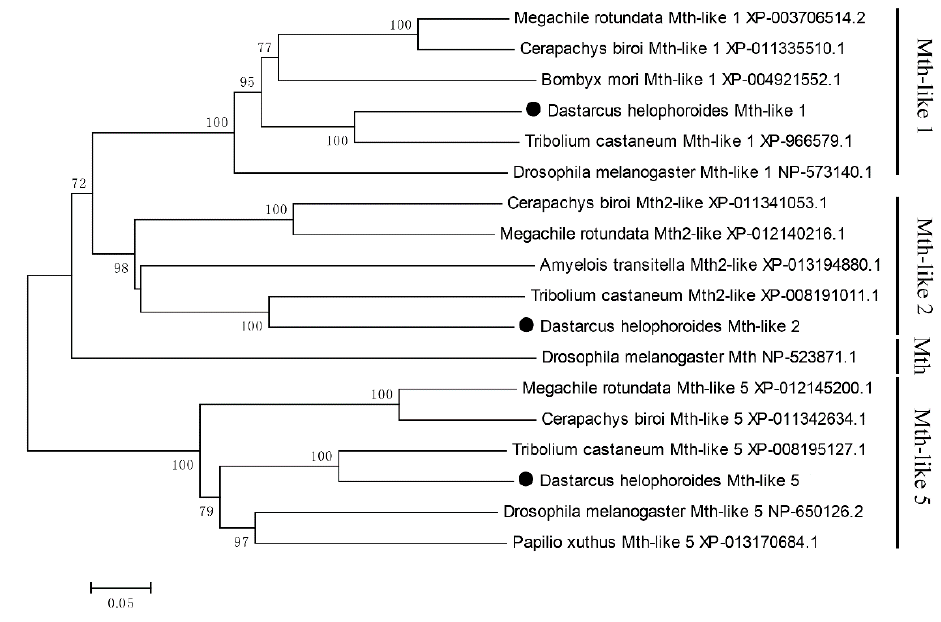
Figure 2. Molecular phylogenetic analysis by the neighbor-joining (NJ) method. Bootstrap values with 1000 trials re-indicated on the branches. GeneBank accession numbers of amino acid sequences used to generate the tree are shown in the Figure. D. helophoroides sequences are marked by a black circle.